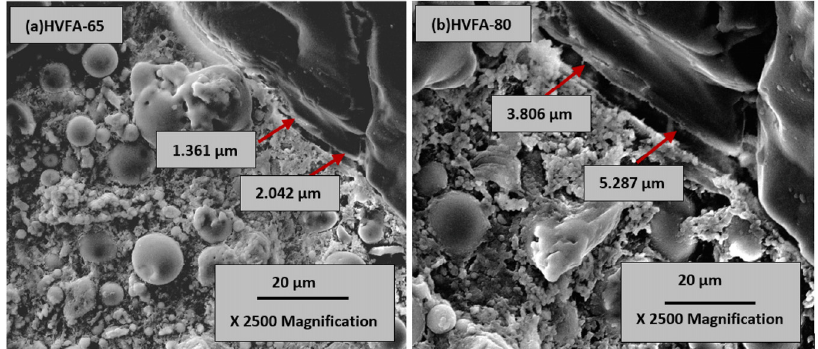
Figure 4. SEM of interface transition zone cracks, the red arrows are the size of them: ( a ) concrete with 65% CFA; ( b ) concrete with 80% CFA [62].